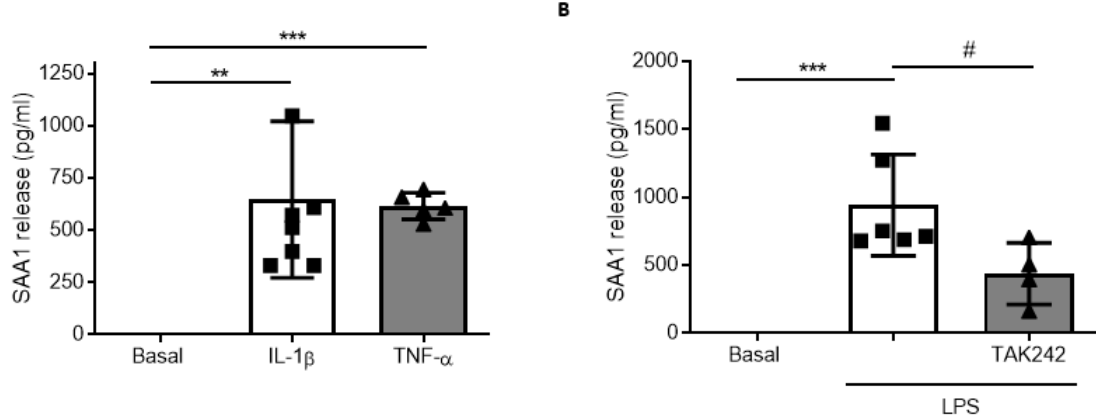
Figure 5. Glial cells synthetized and released SAA1 after inflammatory stimuli. ( A ) Recombinant proteins IL-1β (10 ng/mL) and TNF-α (10 ng/mL) produced the release of SAA1 (detected by ELISA) to the culture medium of mixed glial cultures (n = 6). * p < 0.05, ** p < 0.01, 2-tailed unpaired t test. ( B ) Primary mixed glial cultures treated with LPS 1 µg/mL stimulated SAA1 release, which was reverted by TAK242 (1 µM) (n = 5). * p < 0.05, *** p < 0.001, # p < 0.05, 1-way ANOVA test with Tukey’s multiple comparisons test. Data of all experiments are represented as mean ± SD.